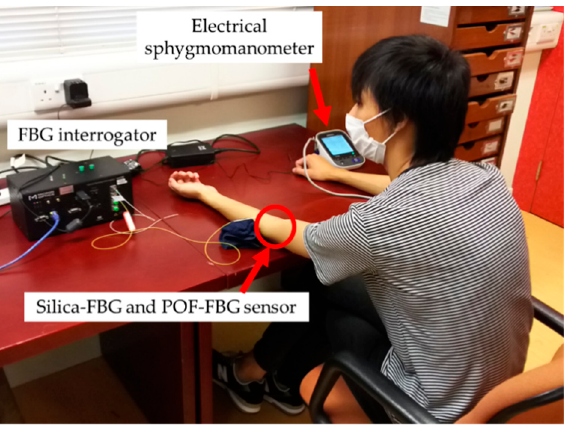
Figure 3. Experimental measurement of a subject.